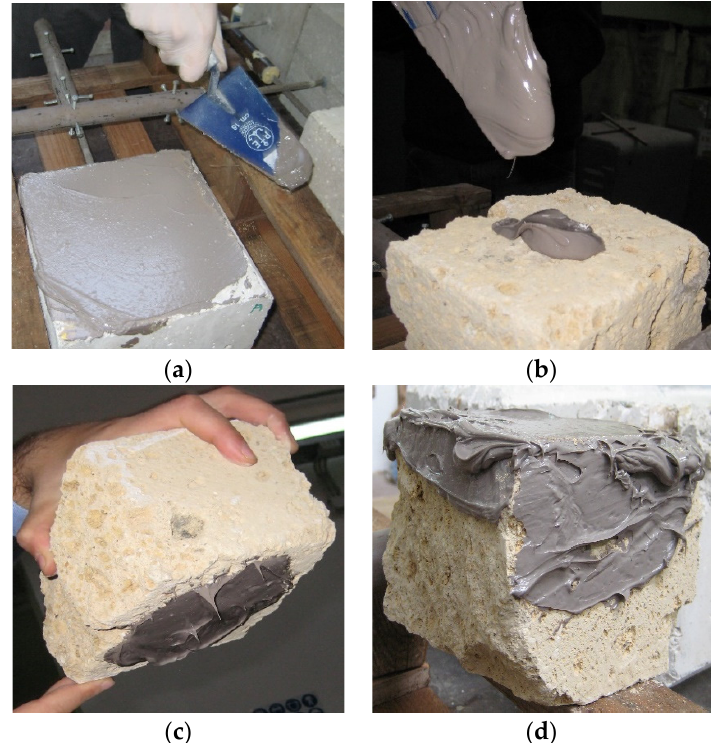
Figure 7. Preliminary adhesion test of MK-PVAc-10 soon after its preparation on different substrates: ( a ) cement; ( b–d ) tuff. A very good thixotropic behavior and very high workability are